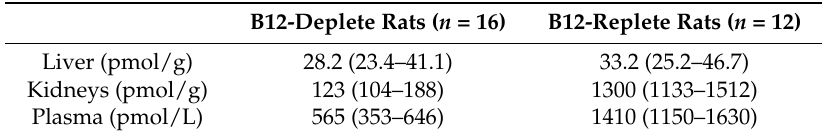
Table 1. Endogenous B12 in liver, kidneys, and plasma of rats kept on low (B12-deplete rats) and high (B12-replete rats) B12 diets for 17 days. Results are given as median with (range).